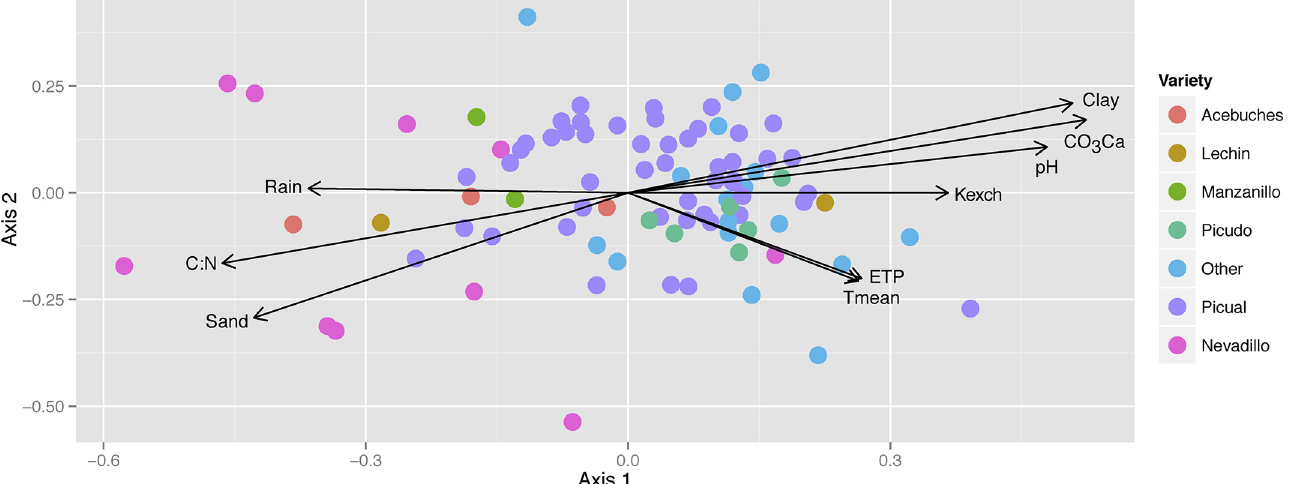
Fig 2. NMDS ordination analysis run for AOB and NOB assemblage composite composition, fitting on it the soil edaphic and climatic factors as environmental gradients significantly associated ( P < 0.05) with the ordination (see Table 2). Samples are highlighted according to the main olive